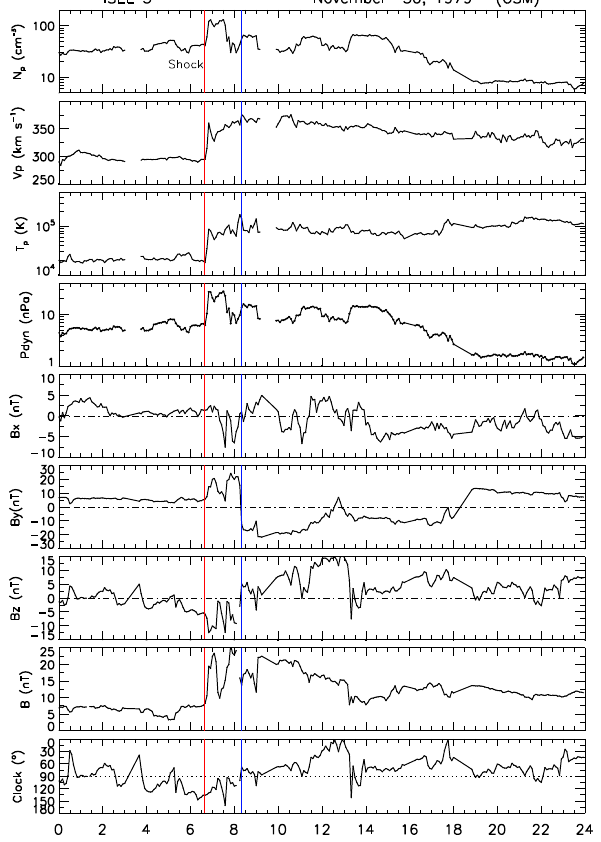
Fig. 1. ISEE 3 data for 30 November 1979: panels from top to bot- tom show proton density, bulk speed, temperature, dynamic pres- sure, magnetic field components B x , B y , B z in GSM coordinates, the total field and the clock angle in the GSM Y-Z plane. The arrival of an interplanetary (IP) shock at approx. 06:35 and the abrupt B y polarity change at approx. 08:20UT are marked by vertical guide- lines.